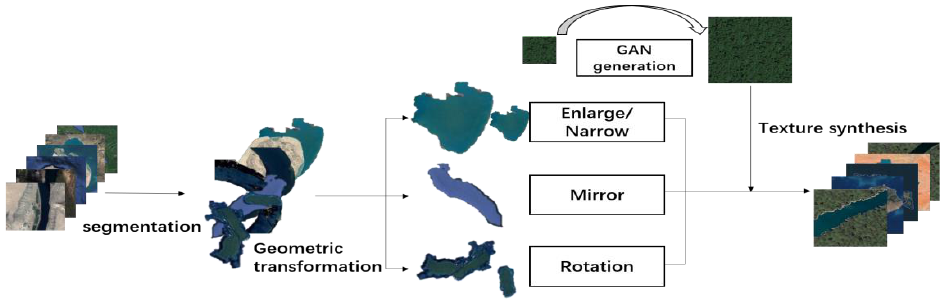
Figure 1. An overview of our proposed